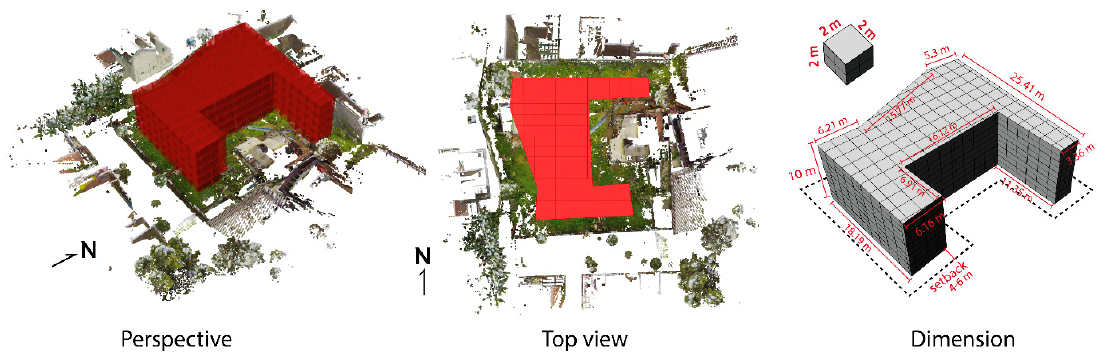
Figure 8. Selected dataset and 3D polyhedra for a case study.